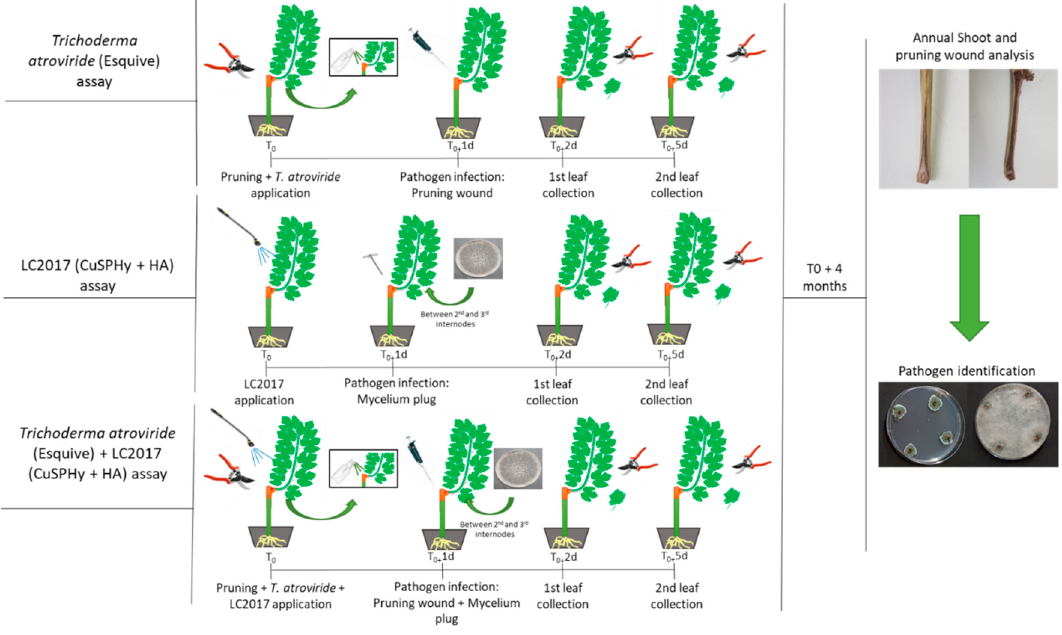
Figure 1. Diagram showing the several steps of treatment and inoculation of greenhouse-kept grapevines of cultivars Cabernet Sauvignon and Touriga Nacional. Information on the treatments and products used can be found in Table 1.